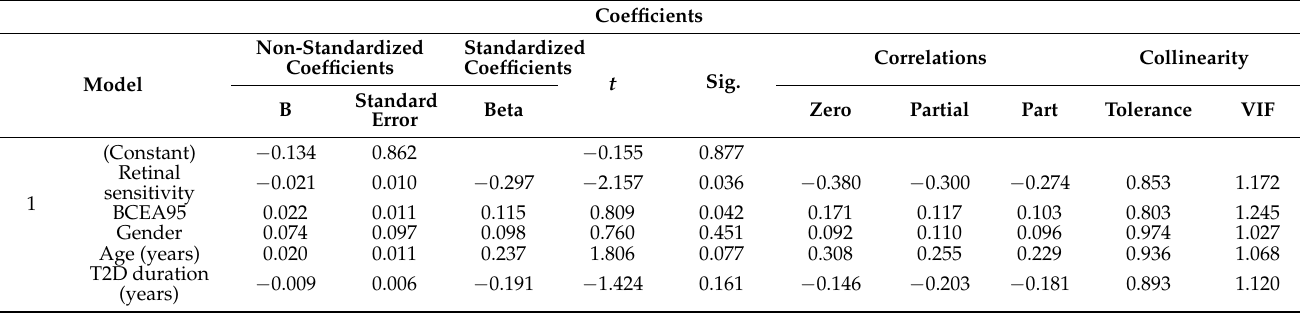
Table 2. Independent predictors of mild cognitive impairment at